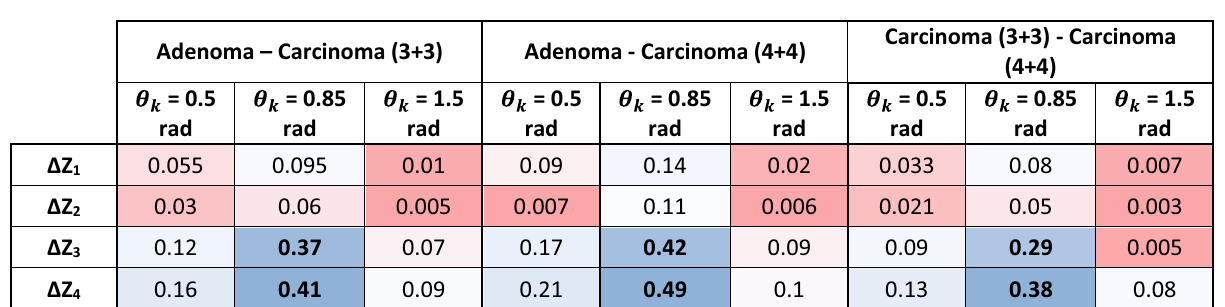
x , y , θ k in (cid:30) (cid:31)